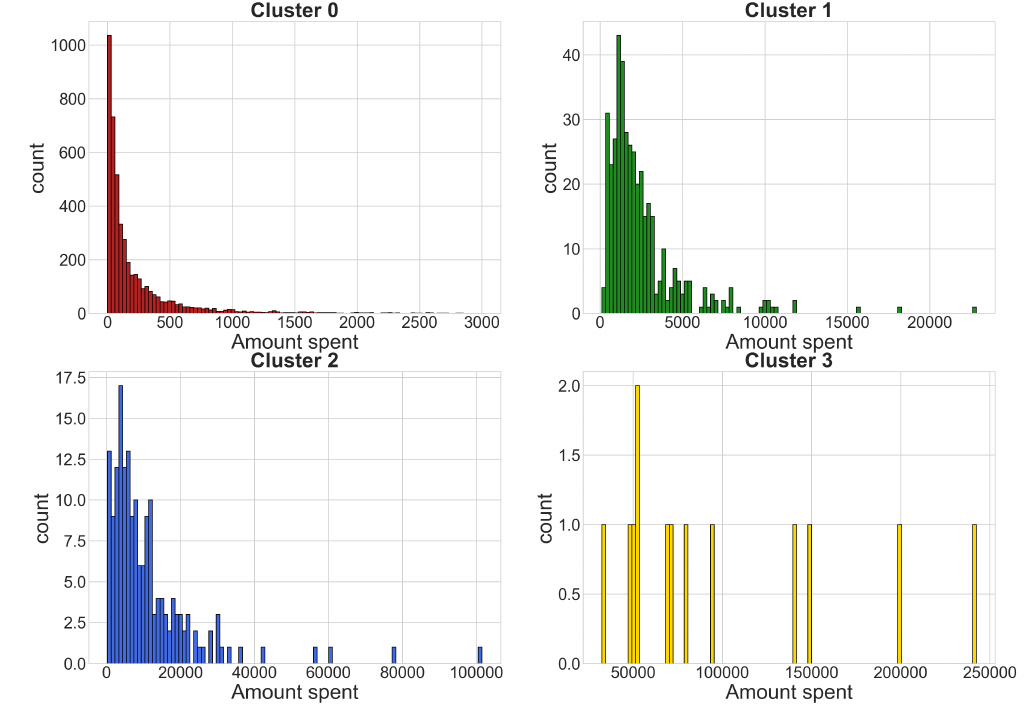
Figure 16. Histograms of the total amount spent obtained using the time series k -means algorithm. The x axis reports the amount spent, while the y axis shows the number of players that have spent that amount during the